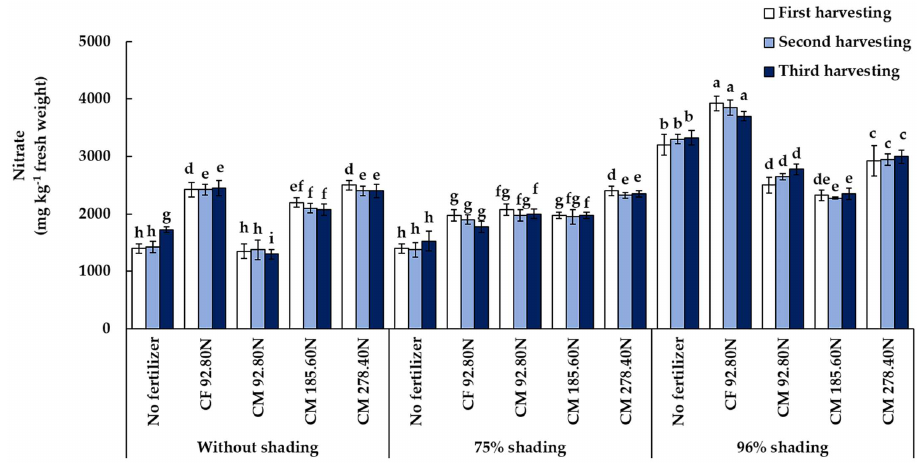
Figure 6. Nitrate content in fiddleheads of vegetable fern grown under different shading and fertilizer application treatments at each harvesting time. Values are means with standard deviations ( n = 4). The different letters above the bars indicate statistically significant differences by Duncan’s multiple range tests ( p < 0.05) within each harvesting month.